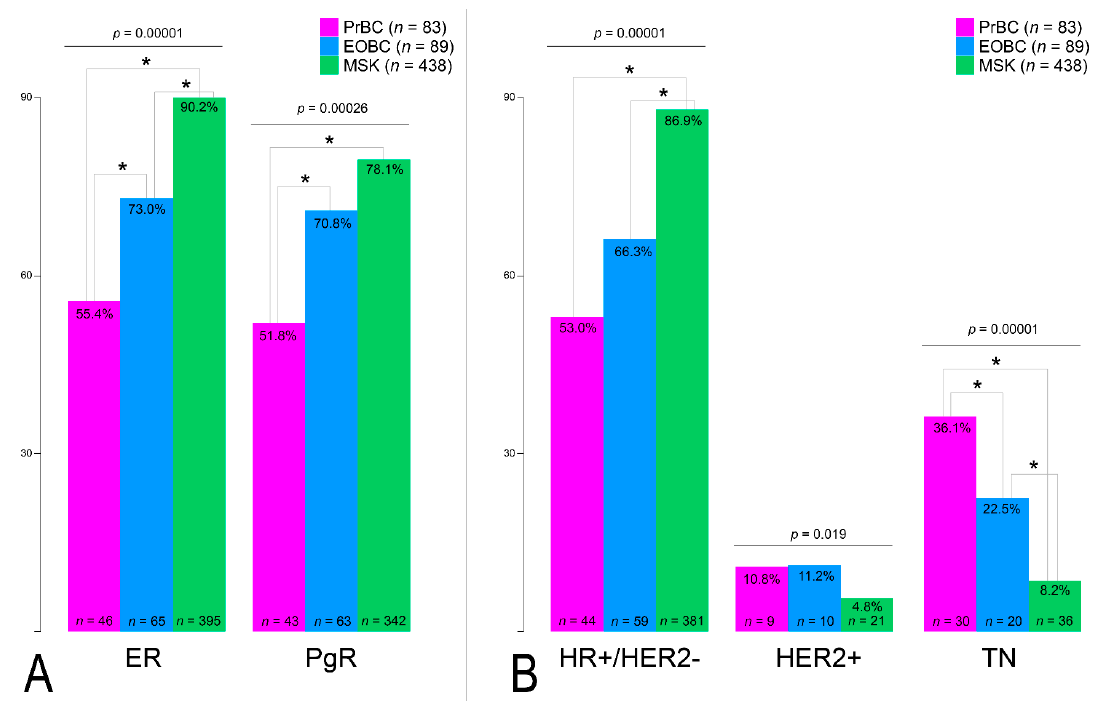
Figure 2. Analysis of biomarker status in the study population and controls. ( A ) Estrogen receptor (ER) and progesterone receptor (PgR) expression. ( B ) Prevalence of the three molecular clusters in the analyzed cases. HR, hormone receptors; TN, triple-negative breast cancer. Significant correla- tions among the different subset of patients (color-coded based on the legend on the right) are high- lighted with a star (*).